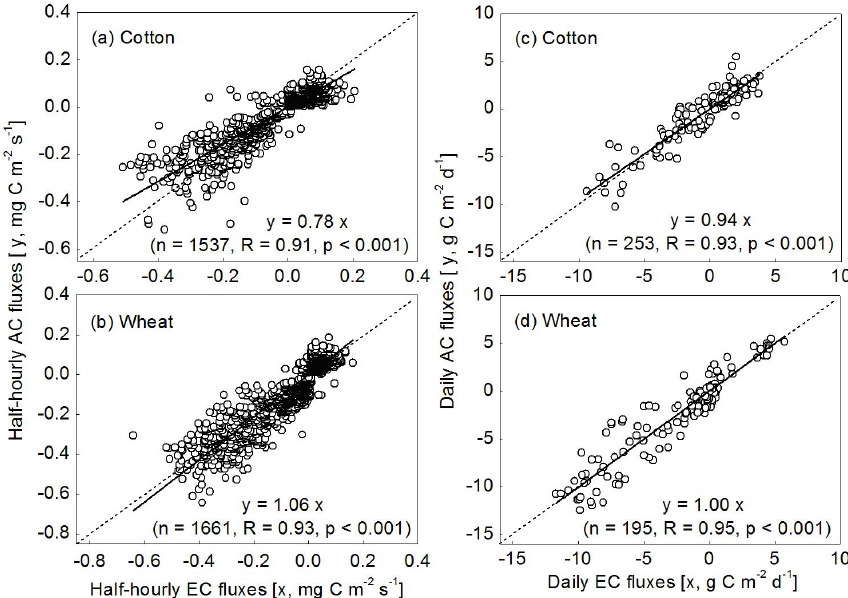
Fig. 6. Comparison of the half-hourly (a, b) and daily (c, d) NEE fluxes between the automatic chamber (AC) and eddy covariance (EC) techniques. (a) and (c) present the data of periods C1 and C3. (b) and (d) show the data of period W2. Definitions of periods C1, C3 and W2 are given in the footnotes of Table 1 as well as in the